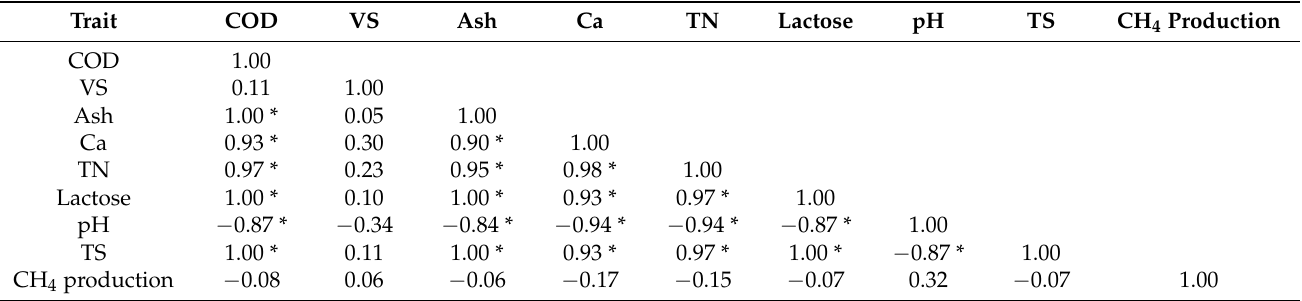
Table 3. The Pearson’s correlation coefficients for the analyzed traits.